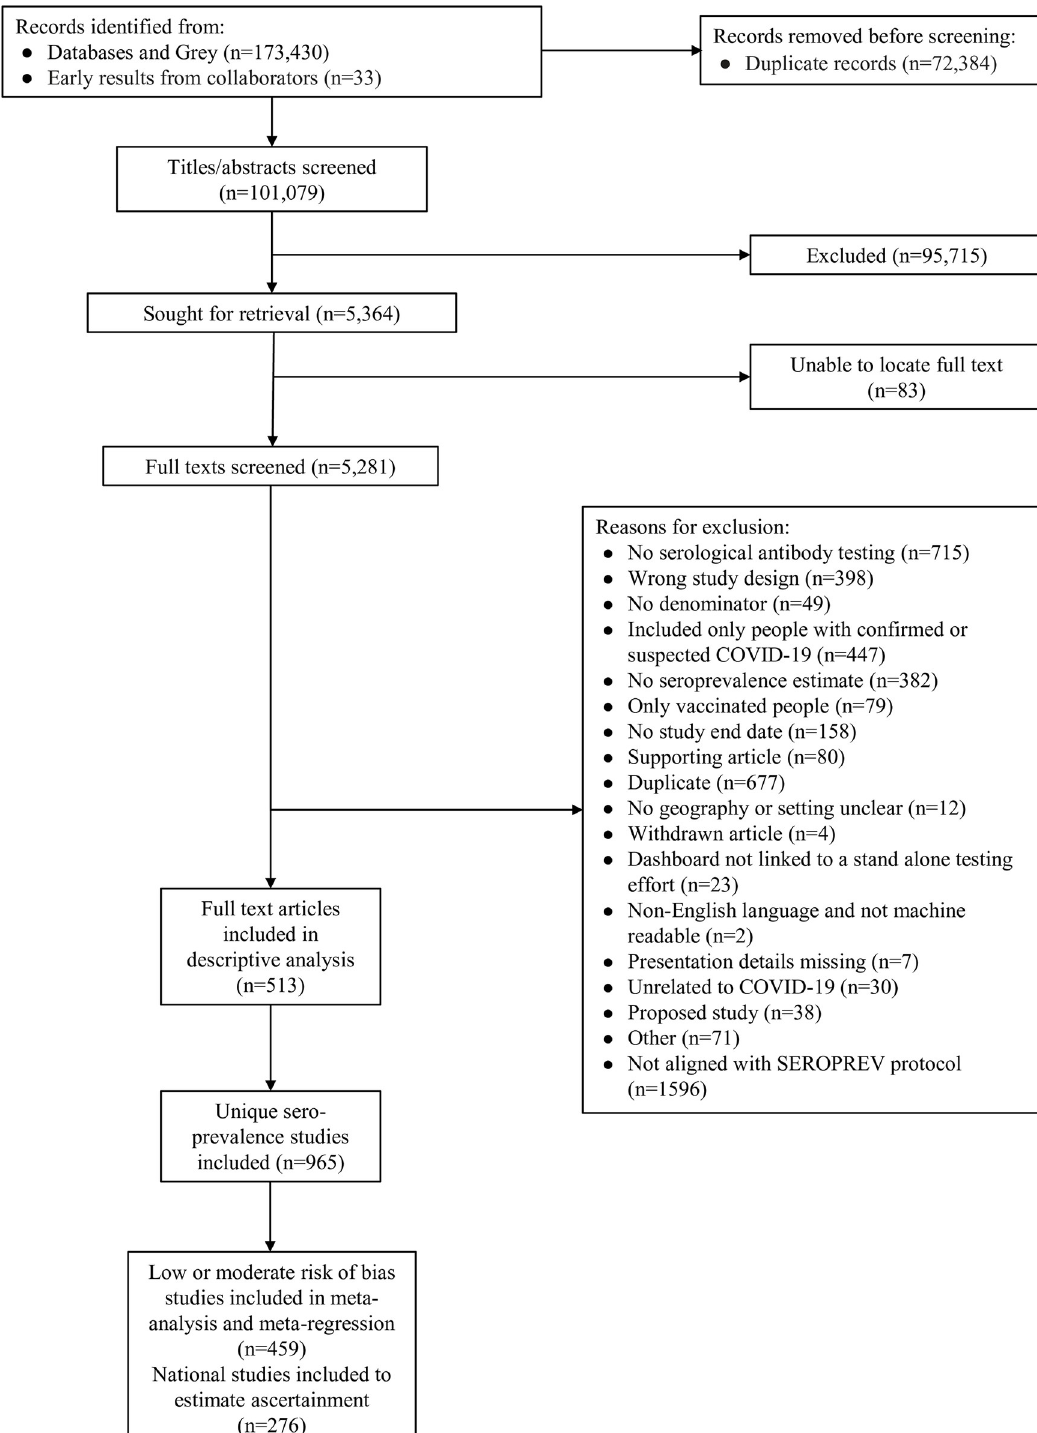
Fig 1. PRISMA flow diagram of inclusion. In cases where sources contained multiple primary estimates of seroprevalence (i.e., in nonoverlapping populations, separate methodological seroprevalence studies reported in the same article, etc.), the source (full text) was split into multiple individual studies included in the analysis. For this reason, we report more unique seroprevalence studies than original full-text articles included.